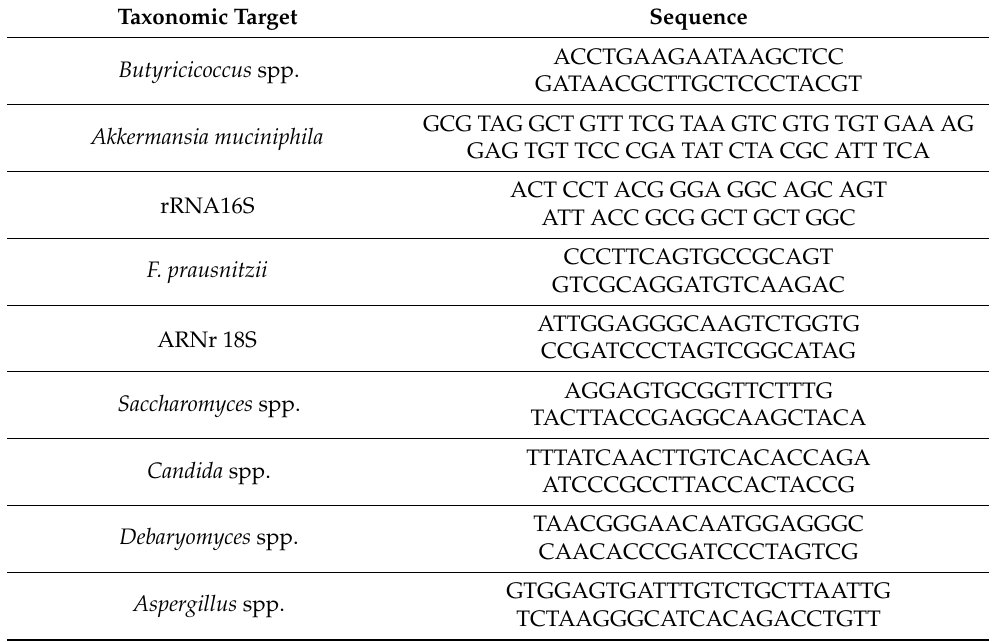
Table 5. Primer sequences targeting 16S rRNA